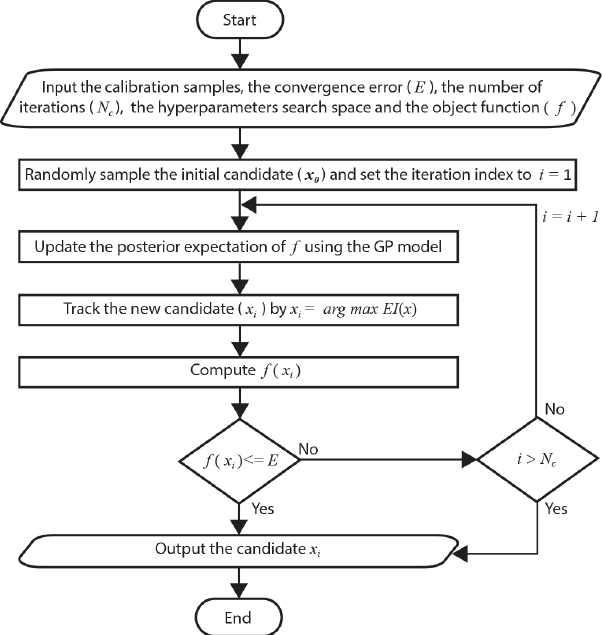
Figure 2. A flowchart of the Bayesian